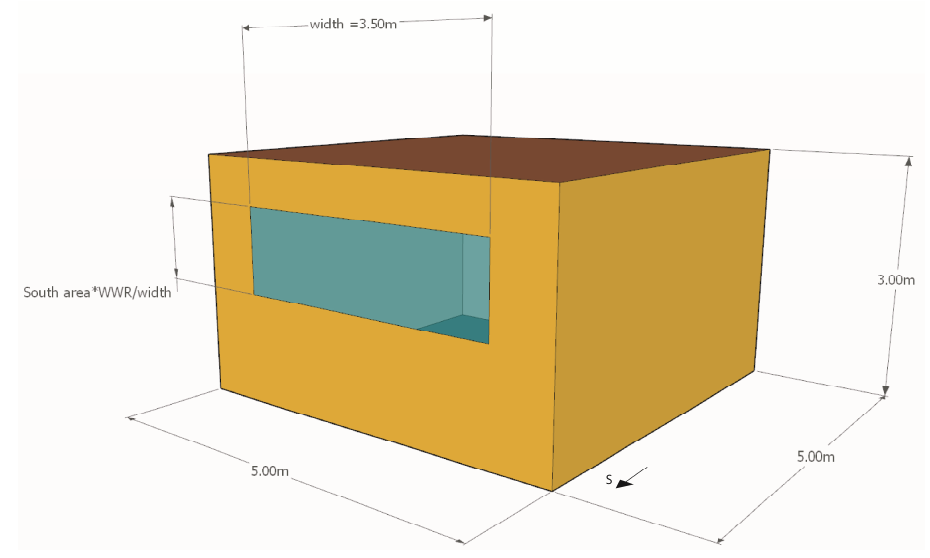
Figure 4. Building model description.